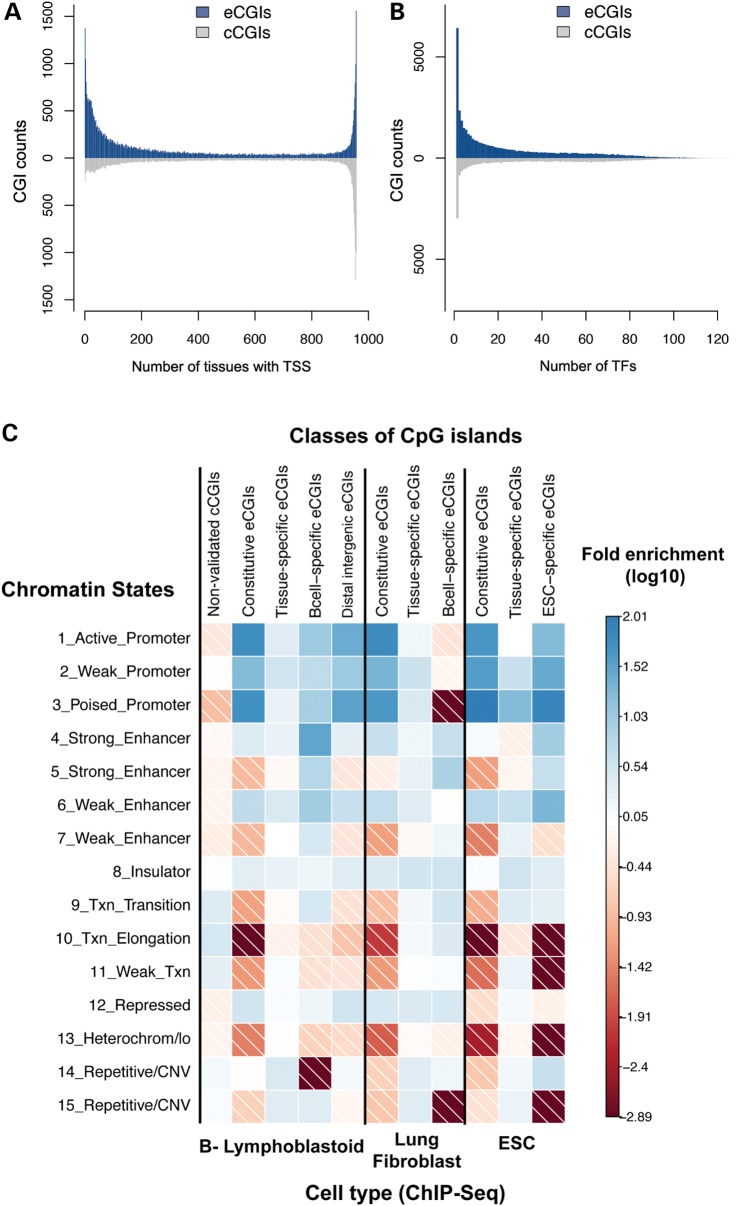
(A) Differing counts of TSS in eCGIs and cCGIs. The X-axis represents the number of FANTOM5 tissues in which a given CGI harbors one or more TSSs (CAGE data). (B) Distinctive TF binding potentials of eCGIs and cCGIs. The X-axis represents the numbers of different TFs that bind to each CGI. Data on specific TF binding were obtained from ChIP-Seq data from ENCODE. (C) Enrichment for chromatin states in different CGI categories. ChIP-Seq based chromatin state maps for three cell types are shown: B-lymphoblastic cells, lung fibroblasts and ESCs. Colors indicate the log10 of the fold enrichment values.